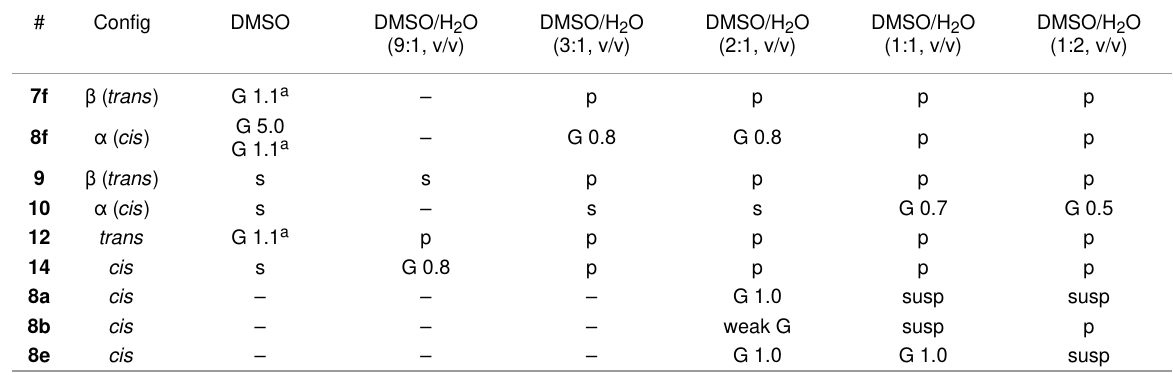
Table 1: Gelation test results for compounds 7f , 8a , 8b , 8e , 8f , 9 , 10 , 12 , and 14 (in % w/w).